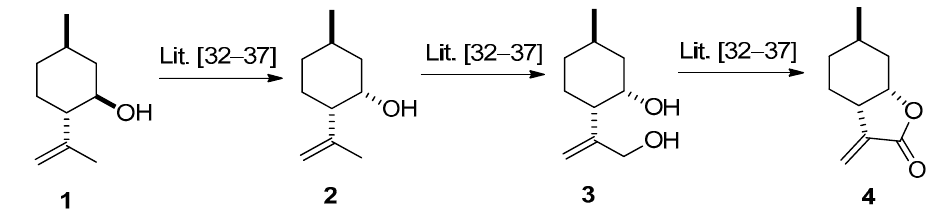
Figure 1. Synthesis of ( − )-isopulegol-based α -methylene- γ -butyrolactone 4.